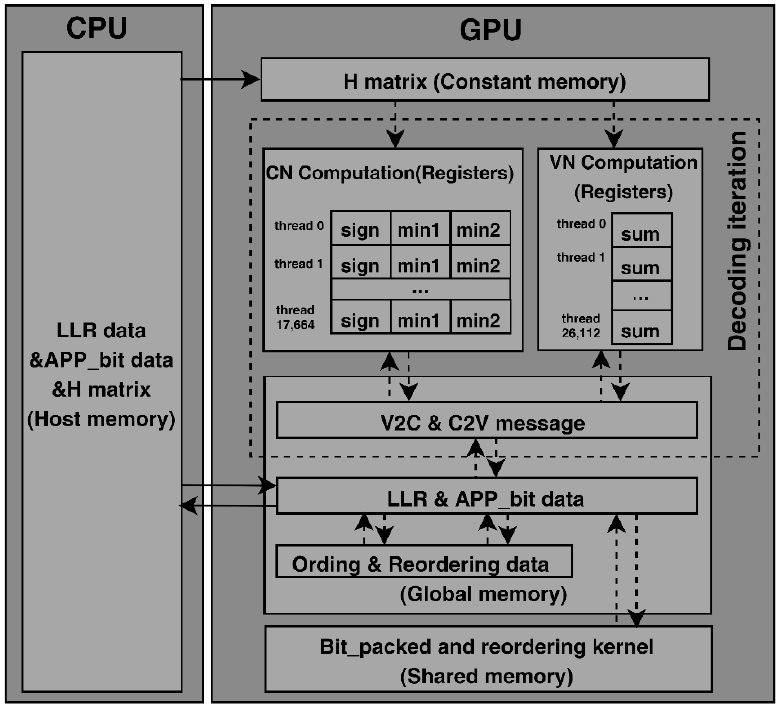
Figure 8. GPU memory allocation strategy of the LDPC decoder.